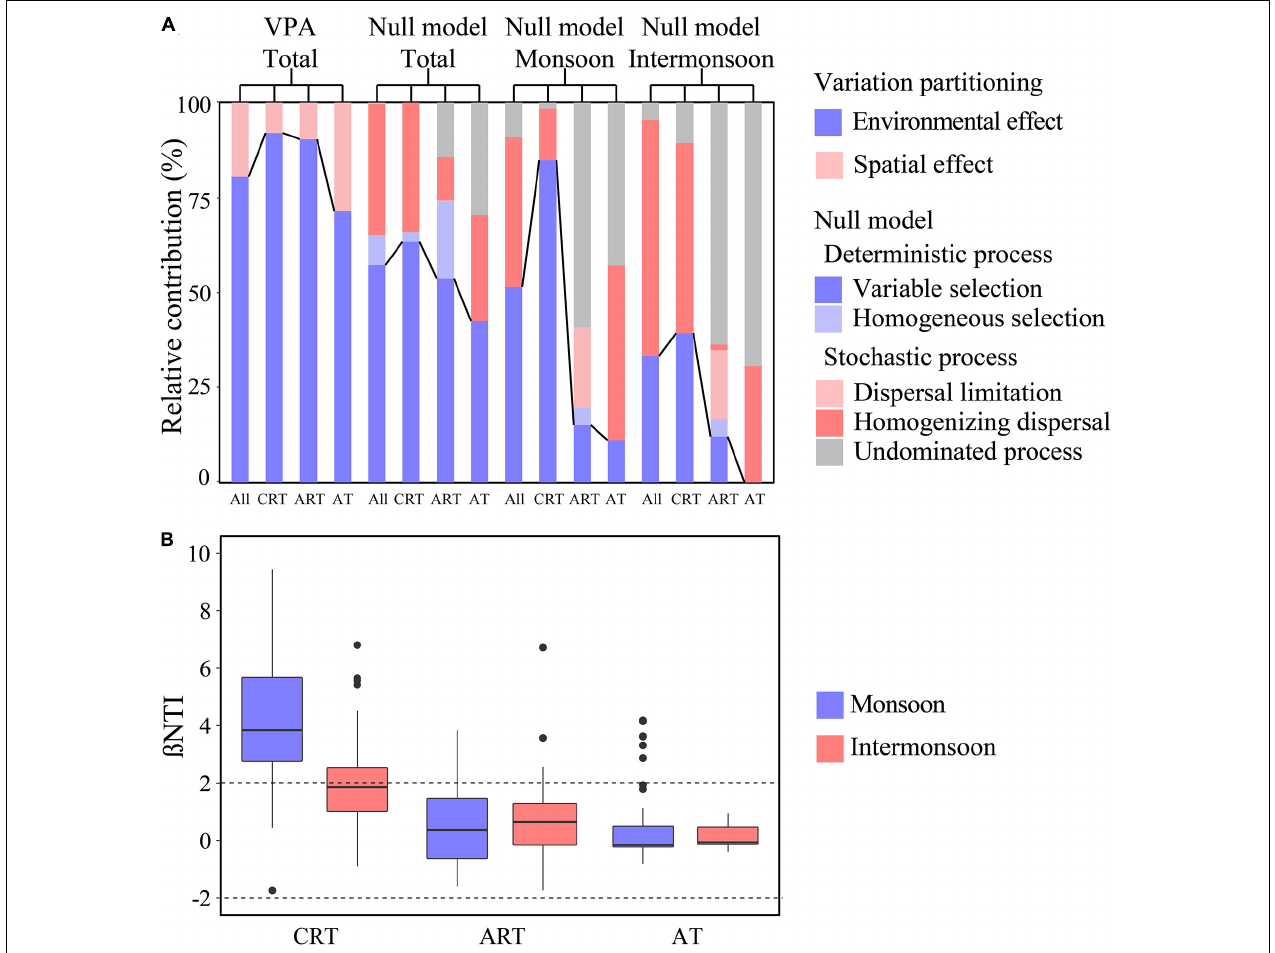
FIGURE 2 | Community assembly mechanisms for different taxa in the monsoon and intermonsoon. (A) The assembly processes of bacterial community in the EIO. Null model: community assembly processes were governed primarily by deterministic processes, including variable and homogeneous selection, and stochastic processes, consisting of dispersal limitations and homogenizing dispersal, as well as the undominated process that was not dominated by any single process. Variation partitioning analysis (VPA) depicting the relative contribution of environmental and spatial effects on microbial community assembly. (B) The seasonal patterns of β NTI for CRT, ART, and AT. CRT, conditionally rare taxa; ART, always rare taxa; AT, abundant